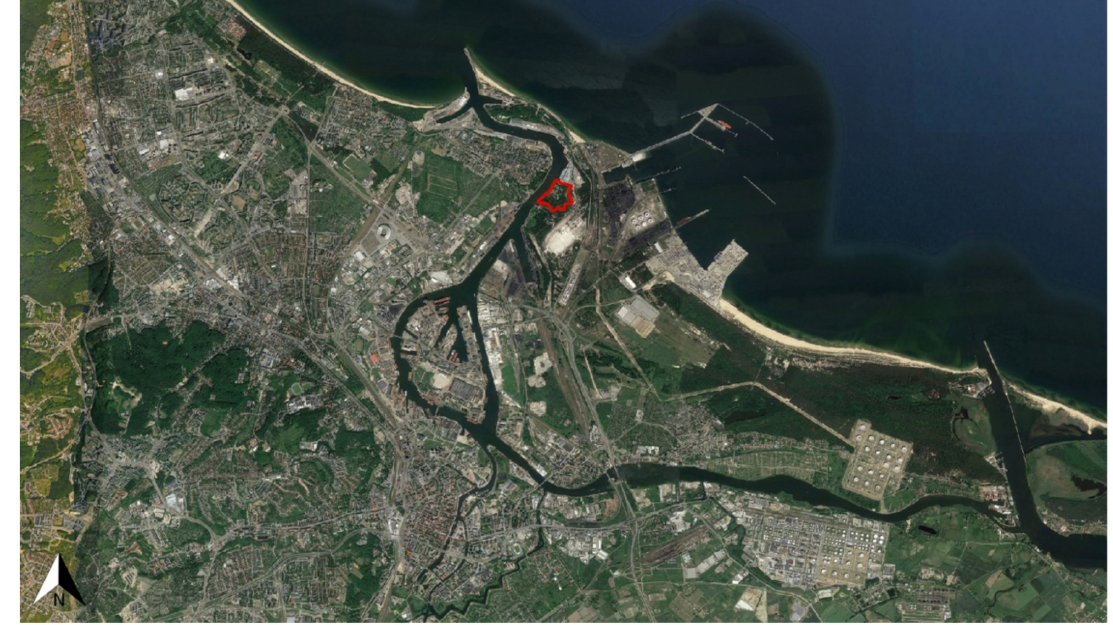
Figure 1. General overview map of the location of the studied area of the Natura 2000 Wisłouj´scie Fortress site in Gdansk, Poland. Scale: NTS. Source: Google